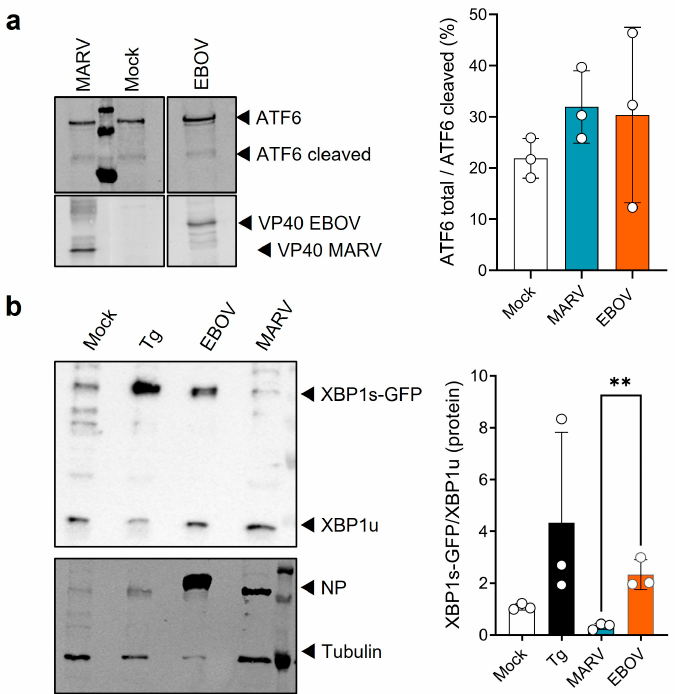
Figure 3. EBOV infection activates XBP1s in HuH7 cells. ( a ) Cells transfected with a Flag-ATF6 plasmid (1 µg) were infected after 24 h p.t. (MOI = 1). Cell lysates were analyzed by western blot using an anti-Flag antibody to detect ATF6 and a virus-specific goat serum to detect viral proteins. Quantification was performed using an Odyssey imaging system. ( b ) Cells transfected with a plasmid encoding Flag-XBP1s-GFP (1 µg) were infected after 24 h p.t. (MOI = 1). XBP1u splicing was induced by 5 nM Tg for 24 h. The cells were lysed at 48 h p.i. and analyzed by western blot using antibodies against the Flag-tag, tubulin and the nucleoproteins of both viruses. XBP1 proteins (XBP1s and XBP1u) were quantified using the ChemiDoc imaging system. Asterisks indicate statistical significance as detailed by bars between groups: ** p ≤ 0.01.